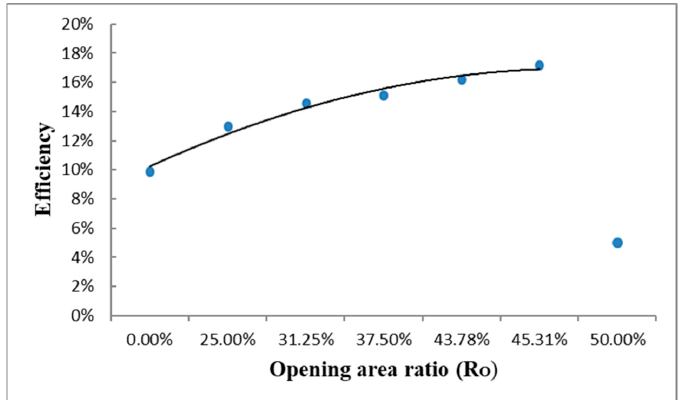
Figure 17. Efficiency corresponding to opening ratio of OWC gate.